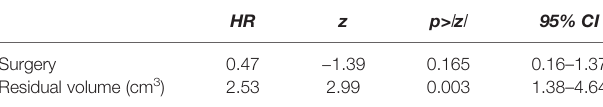
TABLE 4 | Cox regression (High-grade